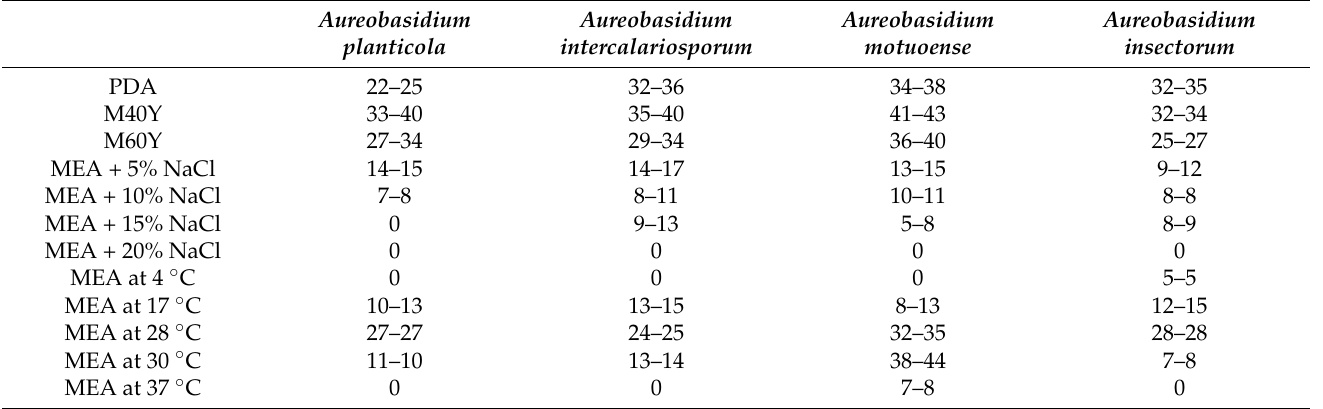
Figure 2. Colony characteristics of analyzed strains. ( A – D ): A. insectorum KCL139 on PDA, PDA, MEA, and OA, respectively. ( E – H ): A. planticola MDSC − 10 on PDA, PDA, MEA, and OA, respectively. ( I – L ): A. motuoense XZY411 − 1 on PDA, PDA, MEA, and OA, respectively. ( M – P ): A. intercalariosporum MQL9 − 100 PDA, PDA, MEA, and OA, respectively. Table 3. Diameter (mm) of four strain colonies under different conditions and on different media. The growth temperature was 25 °C unless noted otherwise and incubation was for 7 d.